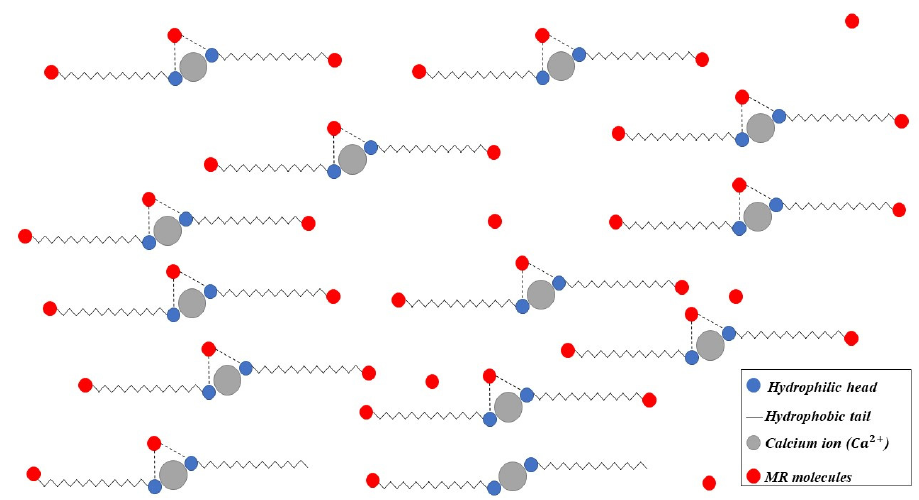
Figure 9. Proposed adsorption mechanism.